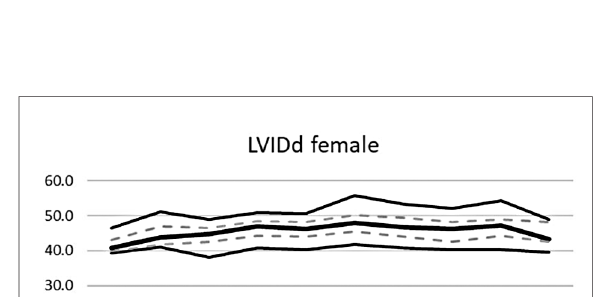
FIGURE 10 Echocardiographic values in dependence of age, LVIDd female.